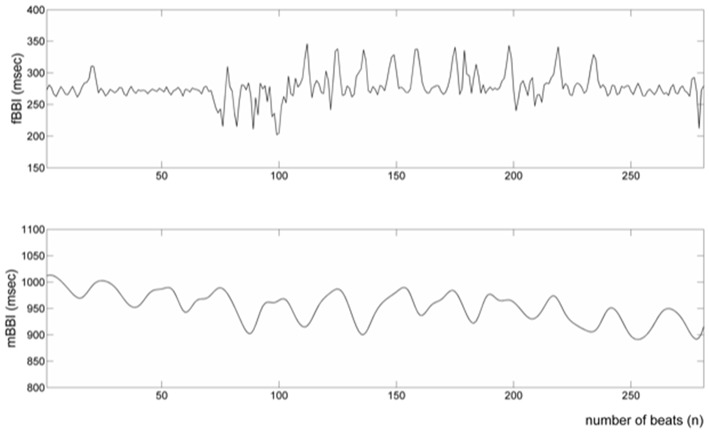
Processed fetal and maternal heart rates (fBBI and mBBI).